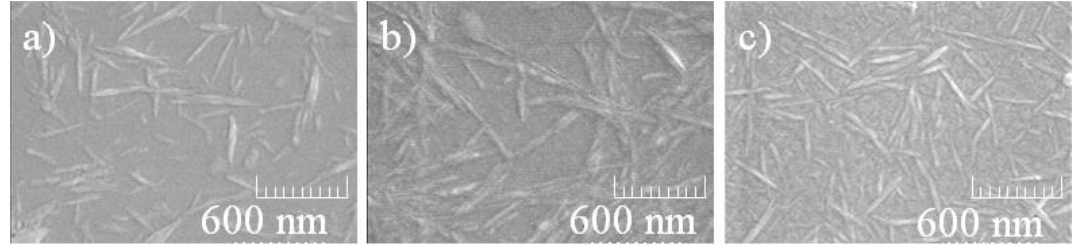
Figure 2. ( a ) SEM images of CNF dispersion with methanol; ( b ) CNF dispersion with DMF; and ( c ) CNF macroinitiator dispersion with